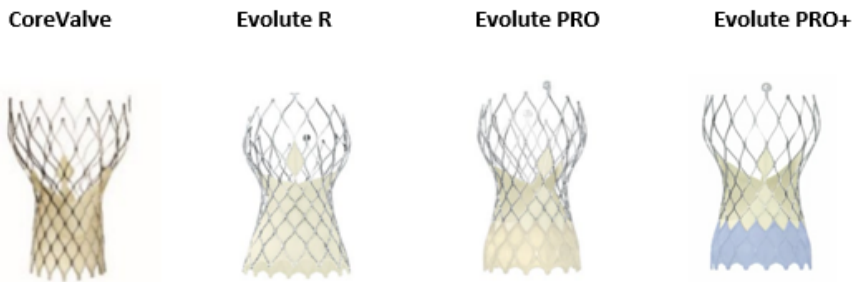
Figure 2. Evolution of the CoreValve/Evolute self-expandable valve. The device consists of self-expanding trileaflet porcine pericardial tissue on a nitinol frame with a larger cell size and a shorter frame height. The external tissue wrap provides advanced sealing.